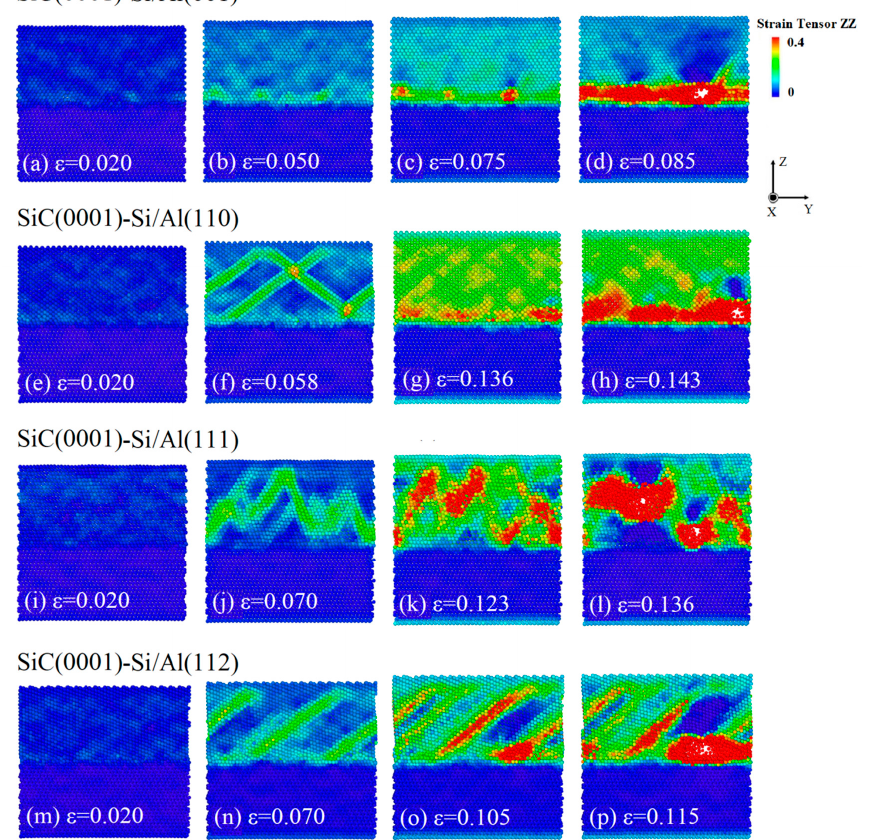
Figure 4. Snapshots of the atomic strain tensor in the Z-direction of four SiC(0001)-Si/Al models at four specific strains: ( a – d ) SiC(0001)-Si/Al(001), ( a ) ε = 0.020, ( b ) ε = 0.050, ( c ) ε = 0.075, ( d ) ε = 0.085; ( e – h ) SiC(0001)-Si/Al(110), ( e ) ε = 0.020, ( f ) ε = 0.058, ( g ) ε = 0.136, ( h ) ε = 0.143; ( i – l ) SiC(0001)- Si/Al(001), ( i ) ε = 0.020, ( j ) ε = 0.070, ( k ) ε = 0.1123, ( l ) ε = 0.136; ( m – p ) SiC(0001)-Si/Al(001), ( m ) ε = 0.020, ( n ) ε = 0.070, ( o ) ε = 0.105, ( p ) ε = 0.115.